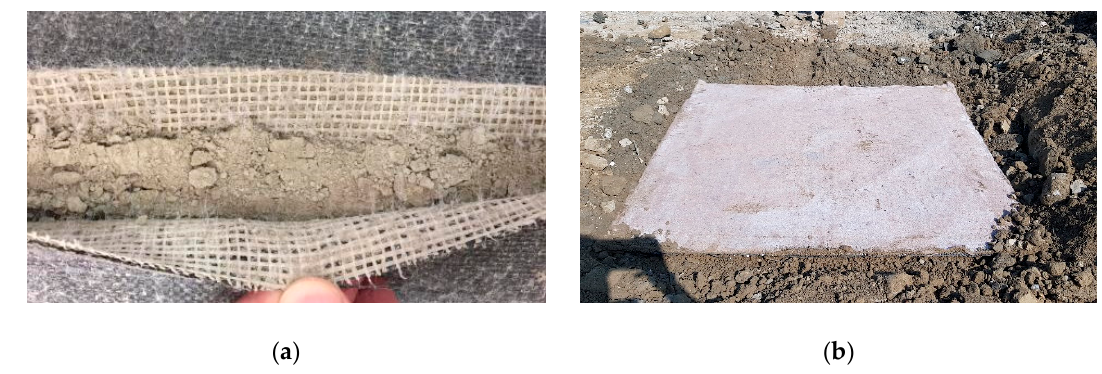
Figure 1. Concrete mat: ( a ) composition of a concrete mat; ( b ) field application example.